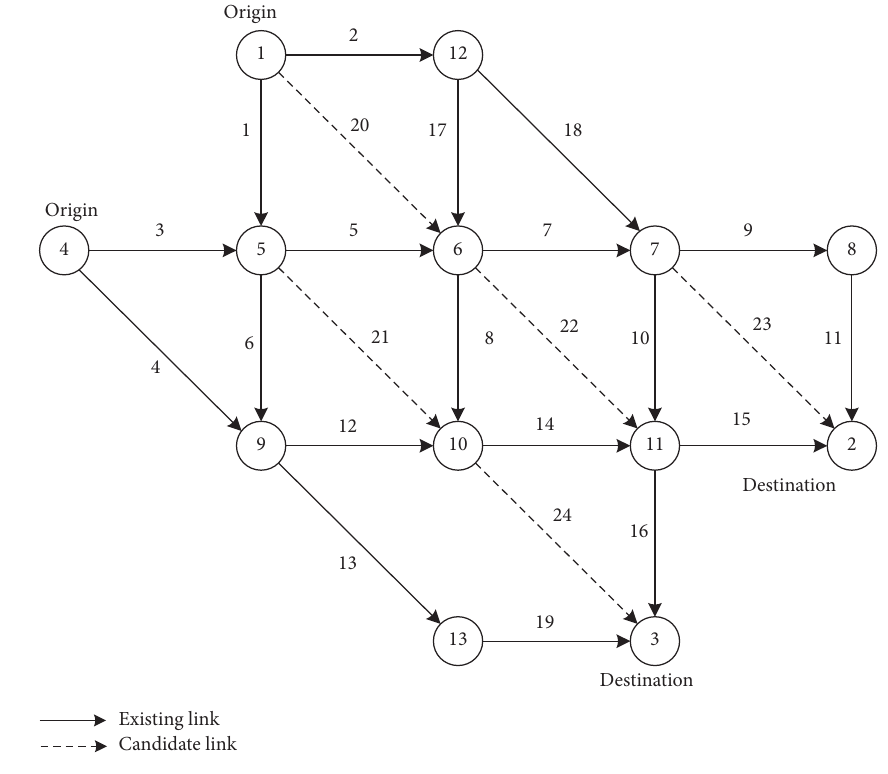
Figure 6: The Nguyen-Dupuis road network. Table 1: Link characteristics of the Nguyen-Dupuis road